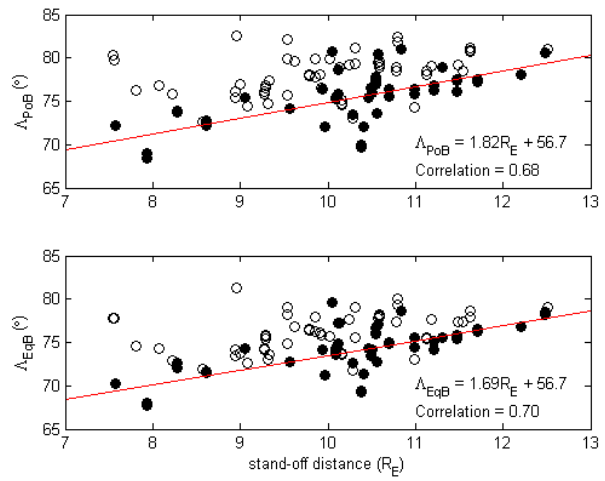
Fig. 16. Poleward and equatorward cusp boundaries versus magne- topause stand-off distance (from Shue et al. model). Filled circles correspond to cases with | B z | > | B y | . Only cases occurring under stable IMF conditions are